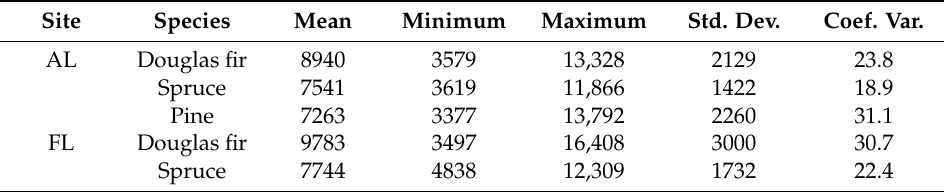
Table 4. Bending strength (in MPa) of individual tree species according to the evaluated site.